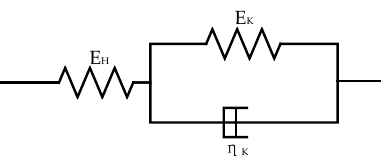
Figure 5. One-dimensional merchant model [36].